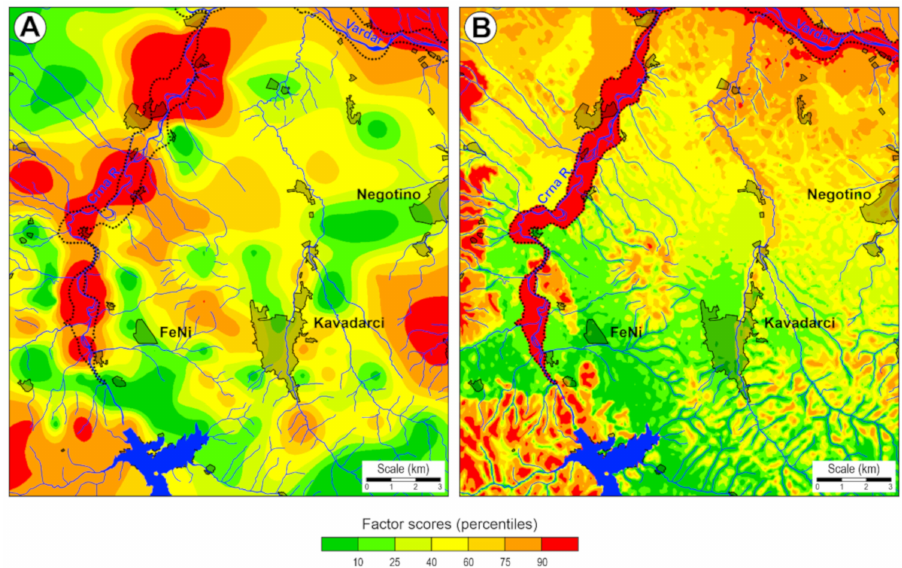
Figure 7. Validation method-Distribution of factor scores (As-Sb-Tl) in Kavadarci area (Macedonia): ( A )—Kriging; ( B )—Artificial neural network—Multilayer perceptron